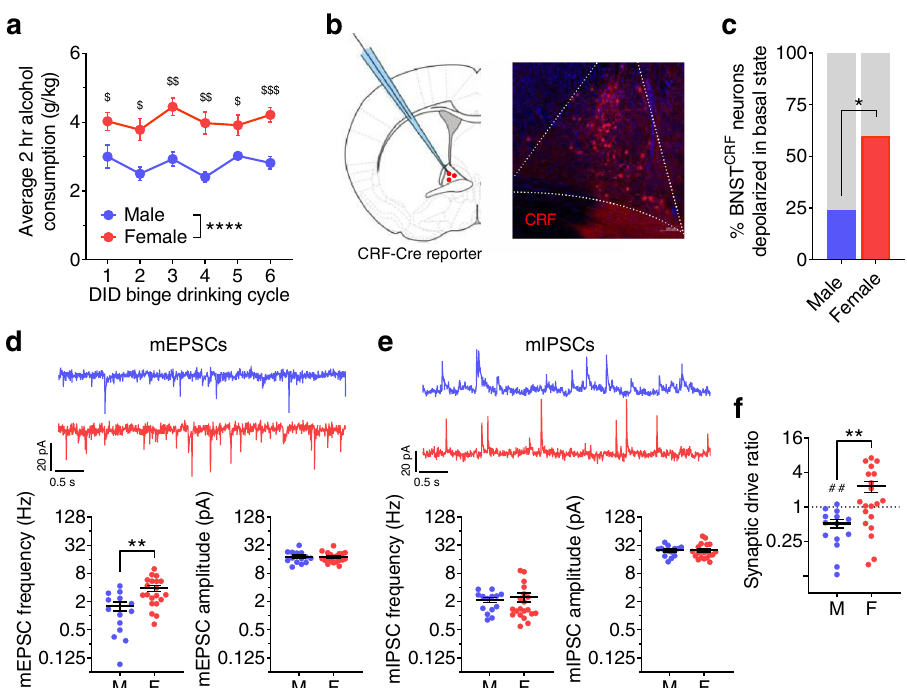
Fig. 1 Females display higher binge alcohol drinking and have greater BNST CRF neuron excitation. a Average 2-h alcohol consumption across cycles of the Drinking in the dark (DID) binge drinking paradigm (N ’ s = 10 M, 10F). 2xRM-ANOVA: main effect of sex ( F 1,18 = 34.81, **** P < 0.0001) and no effect of cycle ( P = 0.101) or interaction ( P = 0.531); post hoc two-tailed t -tests with Holm-Sidak corrections within-cycle show sex differences on all cycles (C1: t = 2.41, $ P = 0.032; C2: t = 3.41, $ P = 0.012; C3: t = 4.69, $$ P = 0.001 C4: t = 4.69, $$ P = 0.003; C5: t = 2.83, $ P = 0.030; C6: t = 5.06, 17 14.8 17.1 12.4 11.3 17.7 $$$ P = 0.0005). b , Schematic of whole-cell patch-clamp recordings of BNST CRF neurons (left) and representative image of a coronal BNST section (right) from a CRF-Cre × Ai9 reporter mouse. c Proportion of BNST CRF neurons active in their basal state (Fisher ’ s exact test * P = 0.021, N ’ s = 13 M, 25 cells; 11 F, 25 cells). d – f Spontaneous (miniature) excitatory and inhibitory postsynaptic currents (mEPSCs and mIPSCs) in the presence of TTX (1 µ M) to block action potential-dependent synaptic transmission in BNST CRF neurons (N ’ s = 3 M, 14 cells; 5 F, 21 cells), compared between males and females using two-tailed unpaired t -tests. d Top: representative traces of mEPSCs in BNST CRF neurons of males (blue, above) and females (red, below). Bottom: mEPSC frequency (left, t 32 = 3.44, ** P = 0.002) and mEPSC amplitude (right, t 32 = 0.06, P = 0.956). e Top: representative traces of mIPSCs. Bottom: mIPSC frequency (left, t = 0.32, P = 0.753) and mIPSC amplitude ( t = 0.13, P = 0.901). f , Synaptic drive ratio, calculated as (mEPSC frequency × amplitude)/(mIPSC 32 32 frequency × amplitude) is higher in females than males ( t 32 = 2.99, ** P = 0.005) and below 1.0 in males (one-sample t -test: t 13 = 4.06, ## P = 0.001)